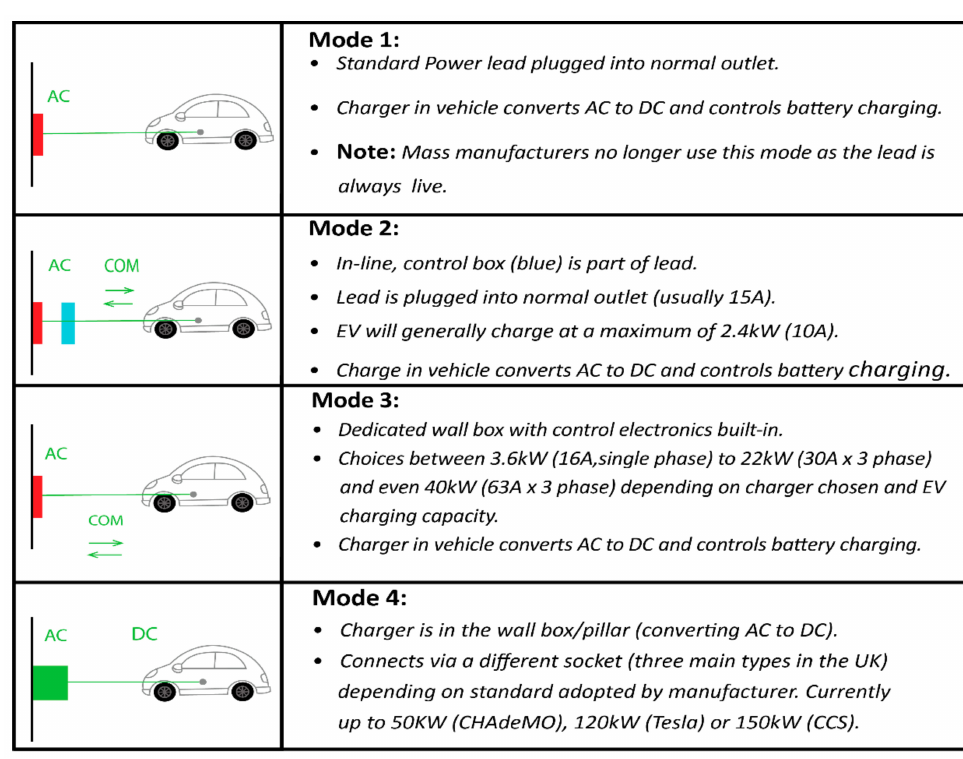
Figure 3. International EV charging modes